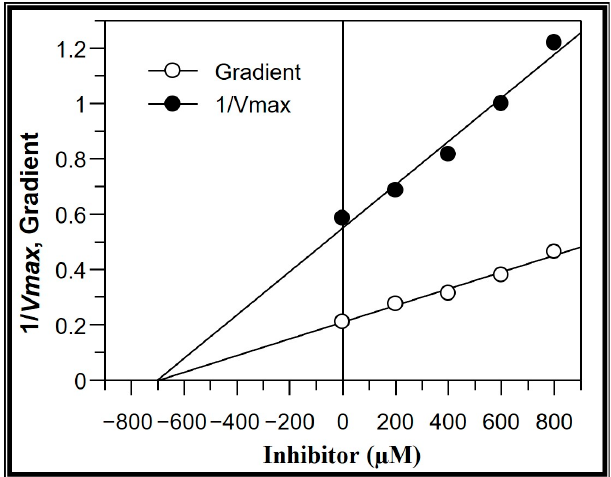
Figure 6. Secondary replots of the Lineweaver–Burk plot, 1/Vmax and gradient vs various concentrations of 1.